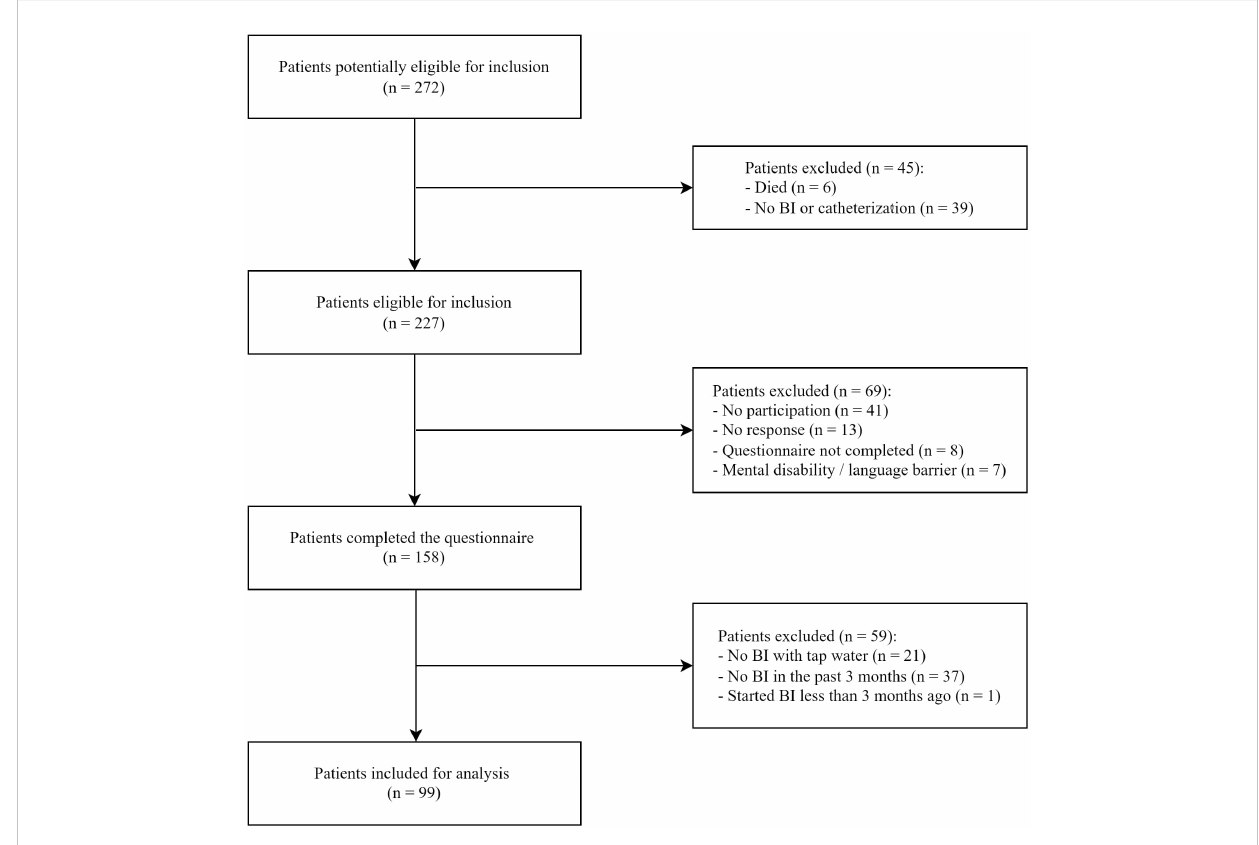
FIGURE 1 Flowchart of patient